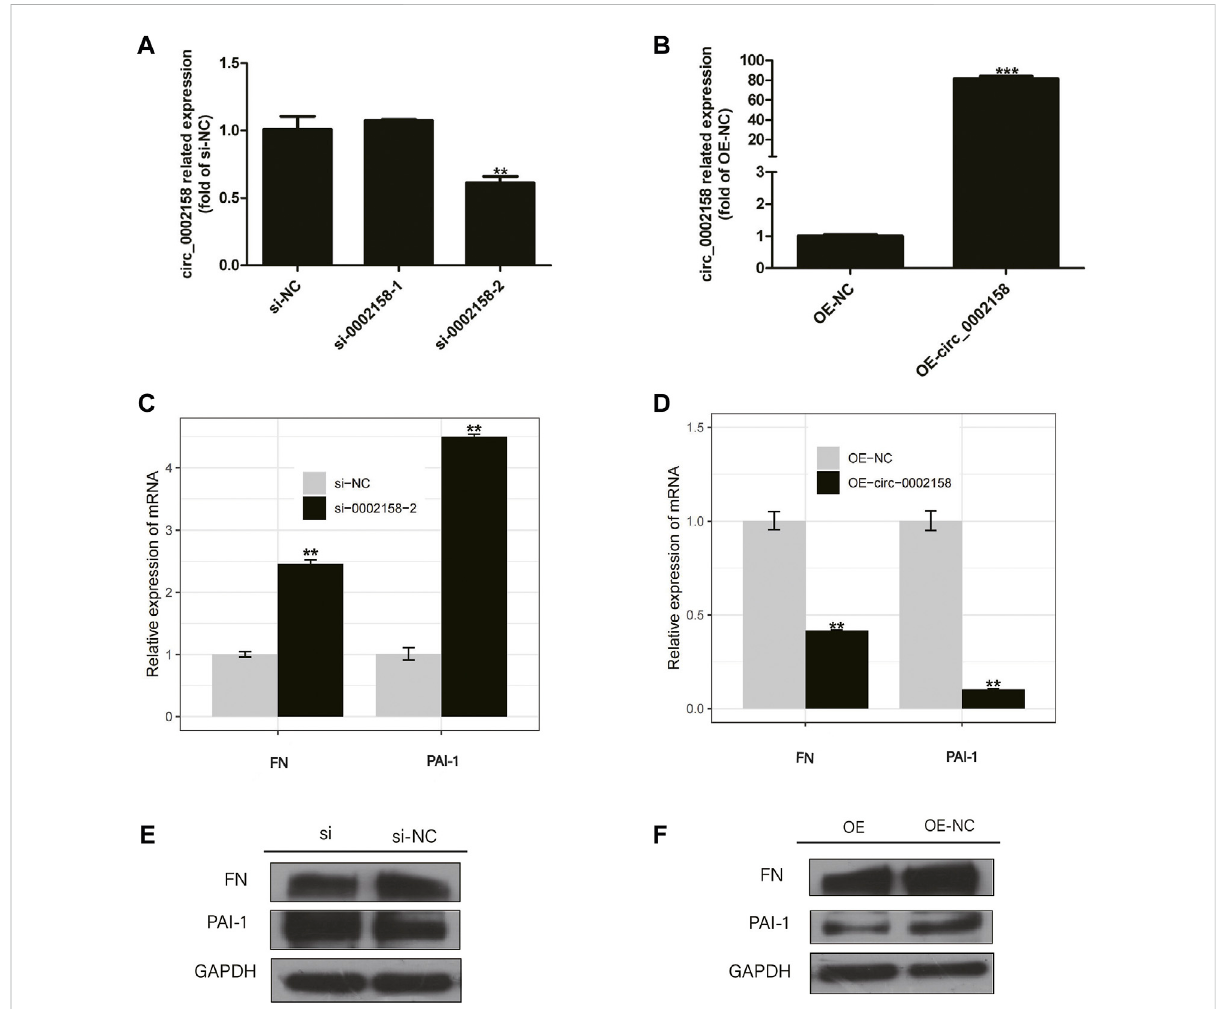
FIGURE 3 Thecirc_0002158regulatingexpressionof fi bronectin(FN)andplasminogenactivatorinhibitor-1(PAI-1). (A,B) HK-2cellsweretransfectedwith siRNAs (circ_0002158 – 1 and circ_0002158 – 2), and plasmids containing circ_0002158. The expression levels of circ_0002158 were detected by qRT-PCR. (C,D) TheexpressionlevelsofFNandPAI-1weredetectedbyqRT-PCRinHK-2cellstransfectedwithsiRNA(circ_0002158 –